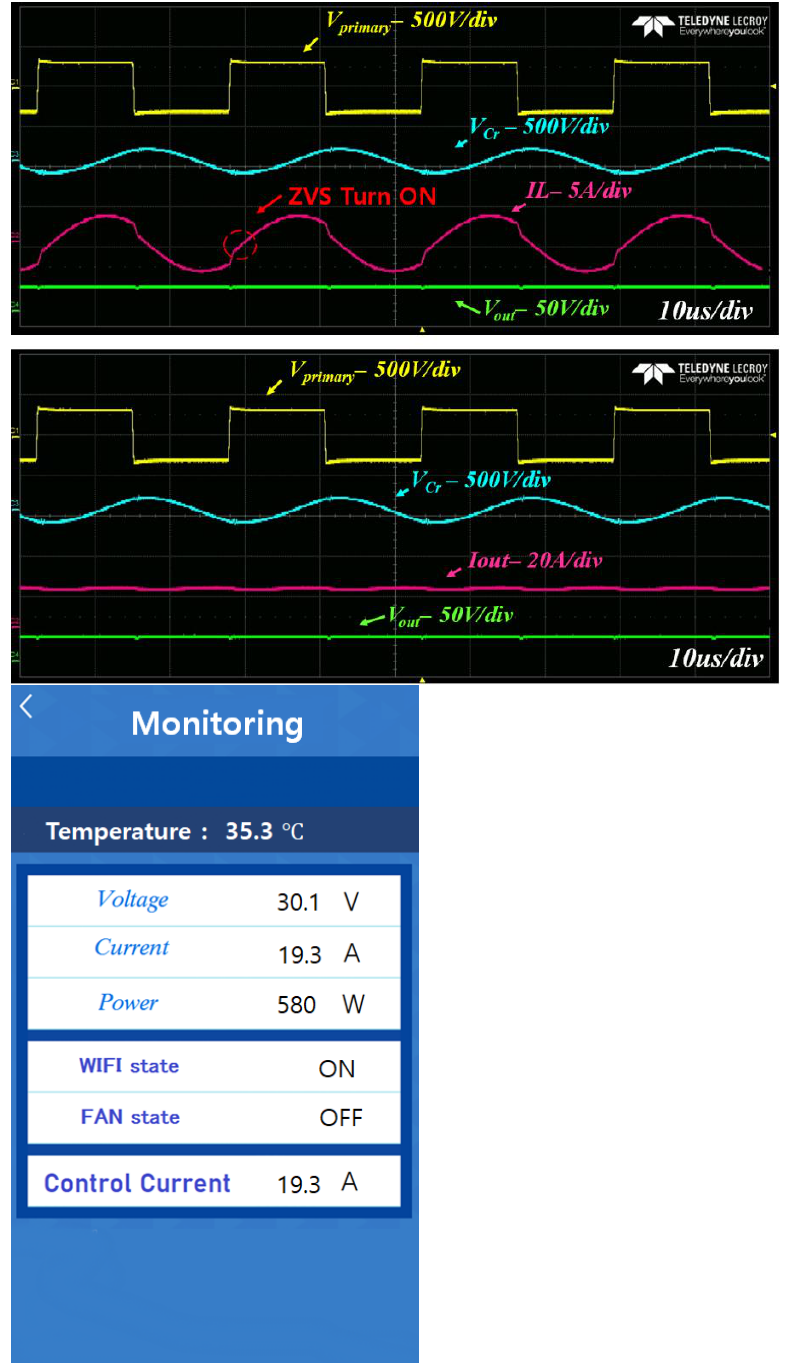
Figure 10. Charging wave form and corresponding smartphone application screen snapshots (Auto mode, Temperature = 35.3 ◦